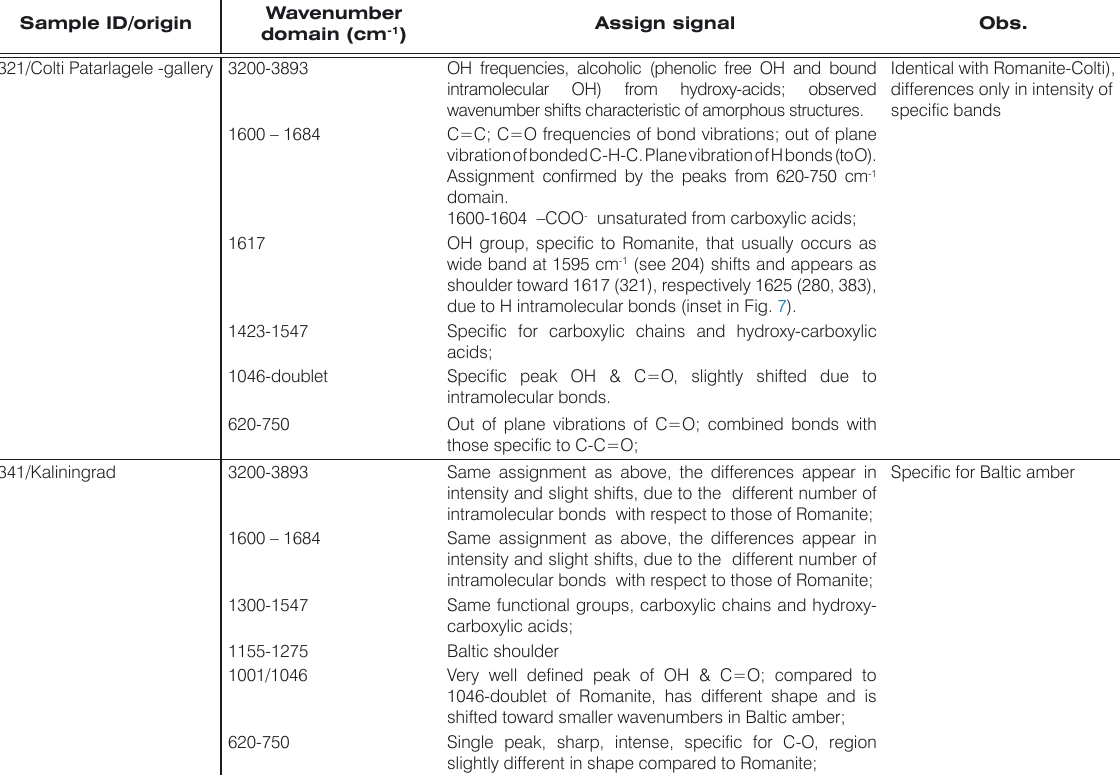
Table 2. FTIR spectra regions of interest for